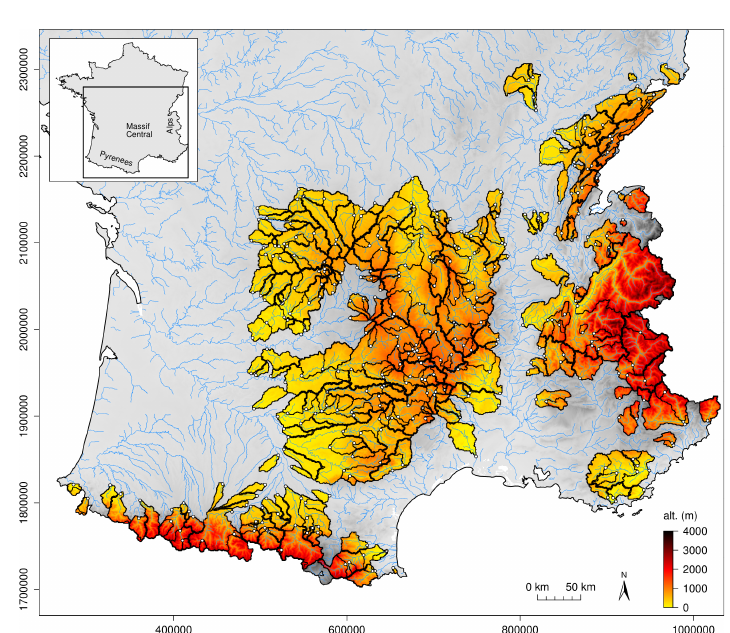
Fig. A1. Locations of the 365 catchments used in the additional testing with the Mouelhi formula and GR4J-CemaNeige model.